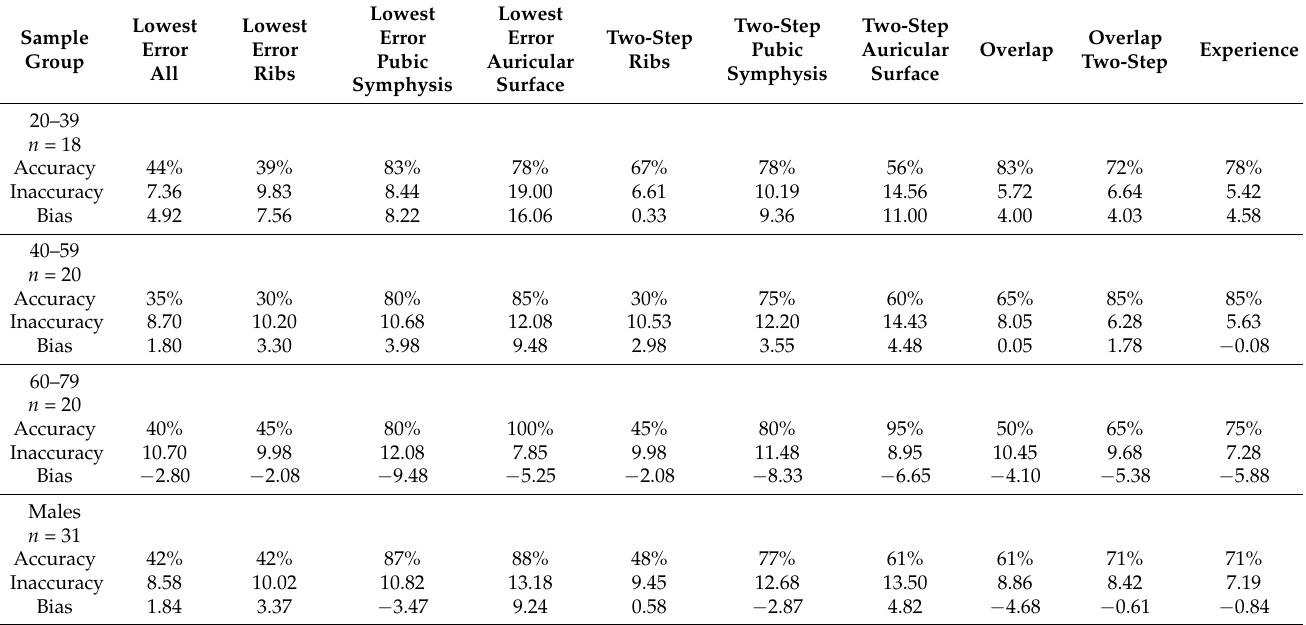
Table 6. Accuracy and reliability (inaccuracy and bias) of age-reporting